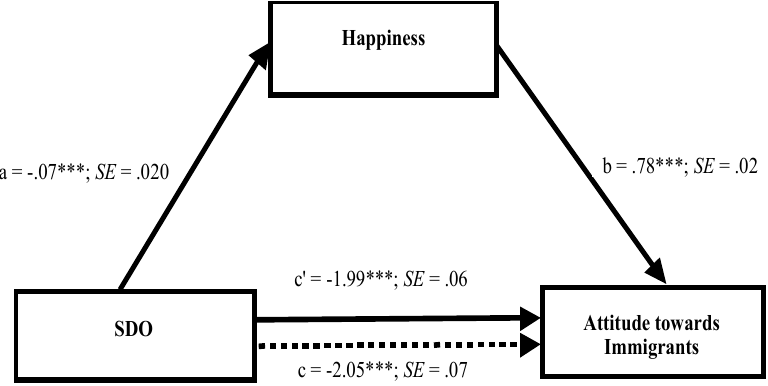
Figure 1. Path coefficients for mediation analysis in the Study. Note: Dotted line denotes the effect of social dominance orientation on attitudes towards immigrants, when happiness is not included as a mediator. a, b, c and c ′ are unstandardized OLS regression coefficients. *** p < 0.001.